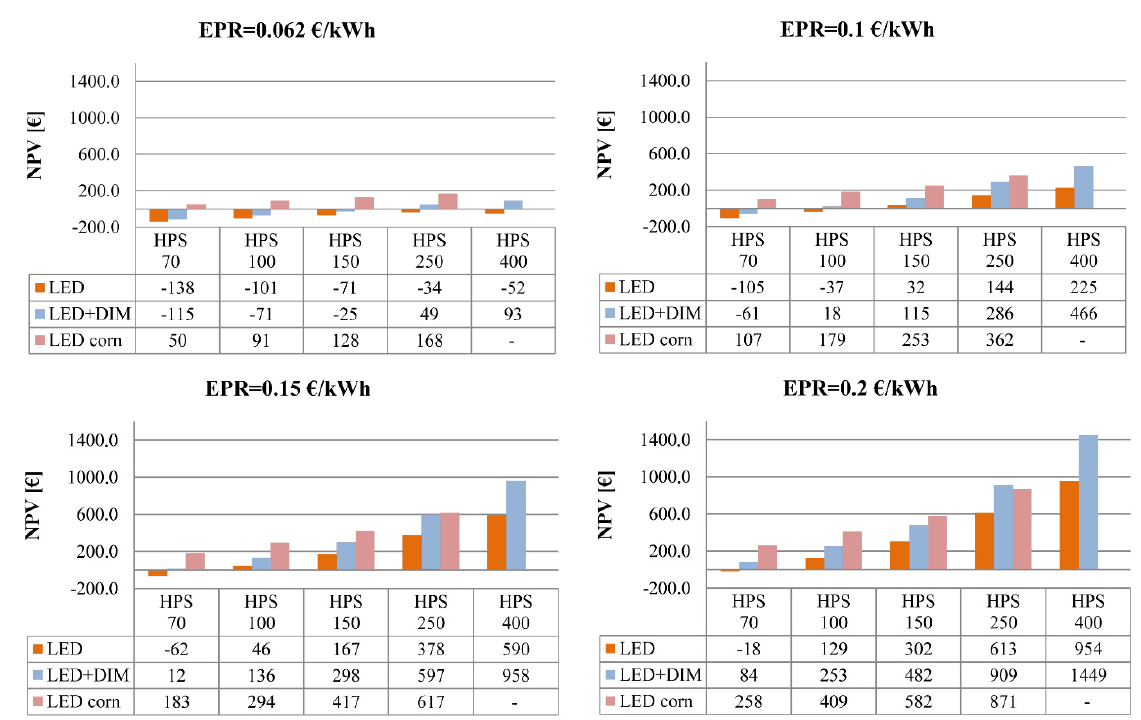
Figure 11. Influence of electricity price on NPV (energy efficiency measures for HPS lamps).